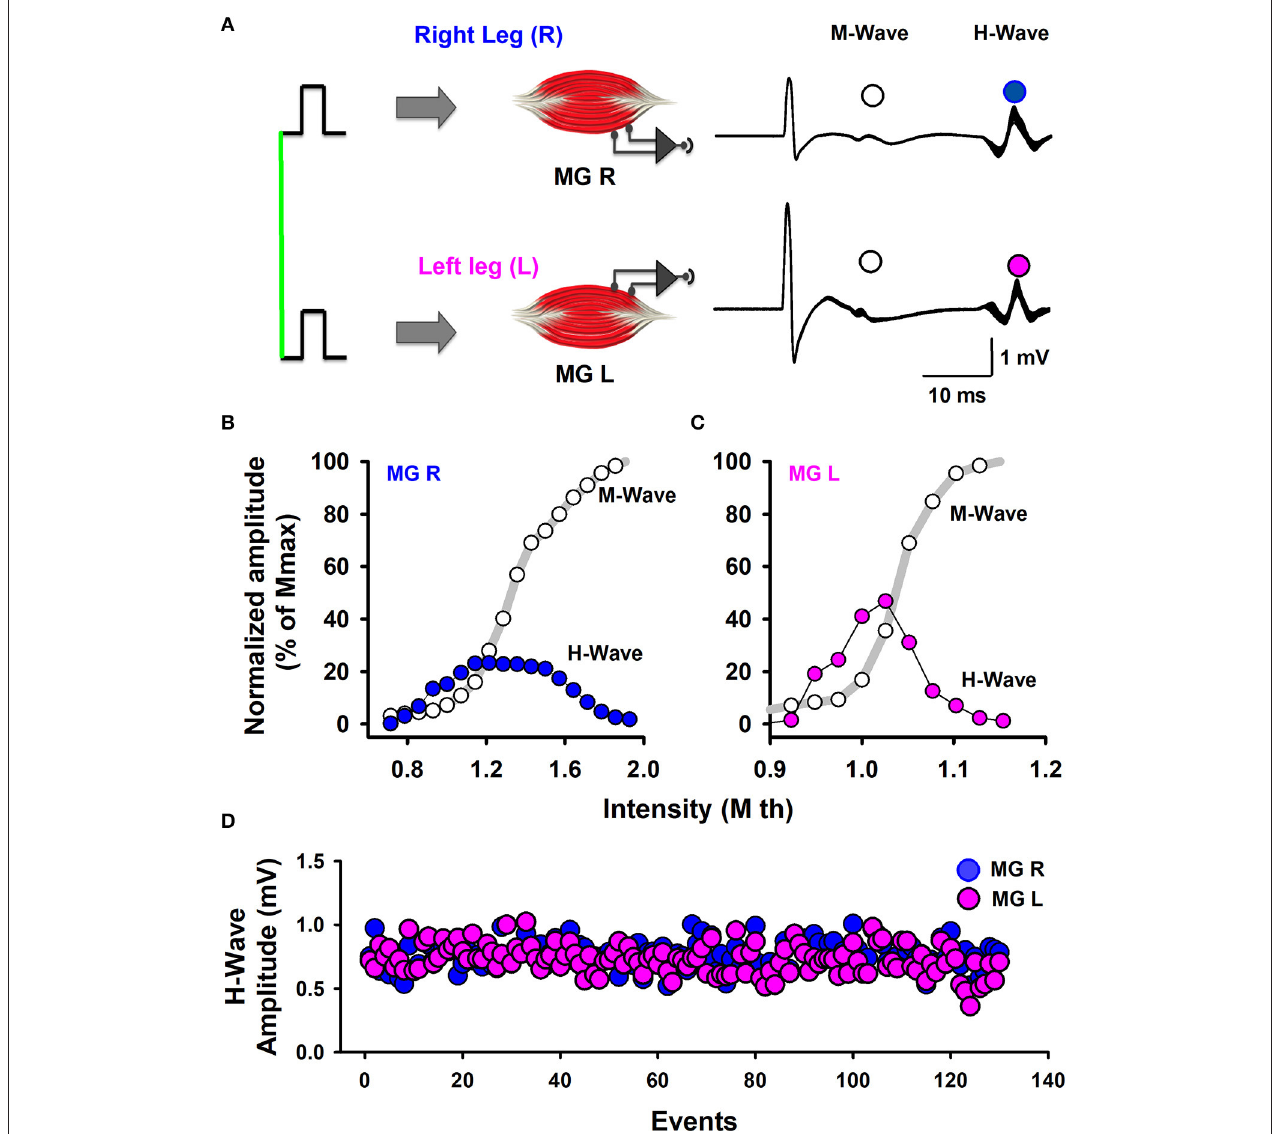
FIGURE 1 | Scheme of the experimental arrangement. (A) Bilateral M-waves and H-waves were elicited by the simultaneous stimulation of Ia-afferents from the left and right legs. MGR is the right medial gastrocnemius muscle. MGL is the left medial gastrocnemius muscle. (B,C) Normalized amplitude of the M-waves and H-waves produced by the stimulation of both legs, as indicated. (D) The sequence of H-wave amplitudes from the left and right